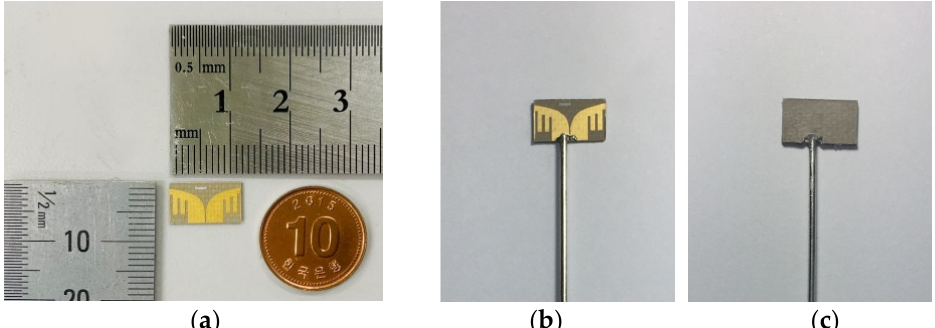
Figure 8. Fabricated antenna prototype: ( a ) antenna printed on a substrate, ( b ) antenna connected to a coaxial cable, and ( c ) antenna covered by a superstrate.